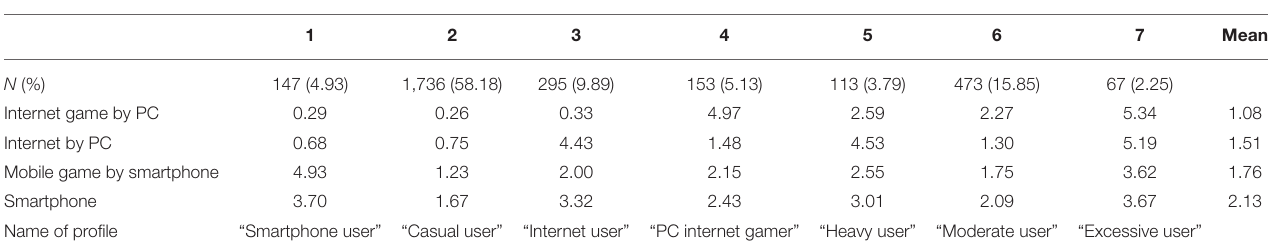
TABLE 4 | Usage time of Internet, Internet game by PC, and smartphone (h).